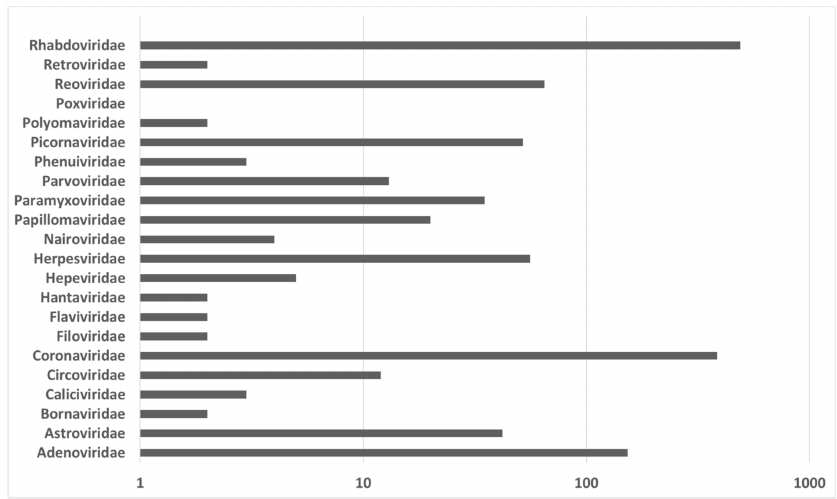
Figure 5. Number of viruses by family recorded for European bats in log scale (DBatVir